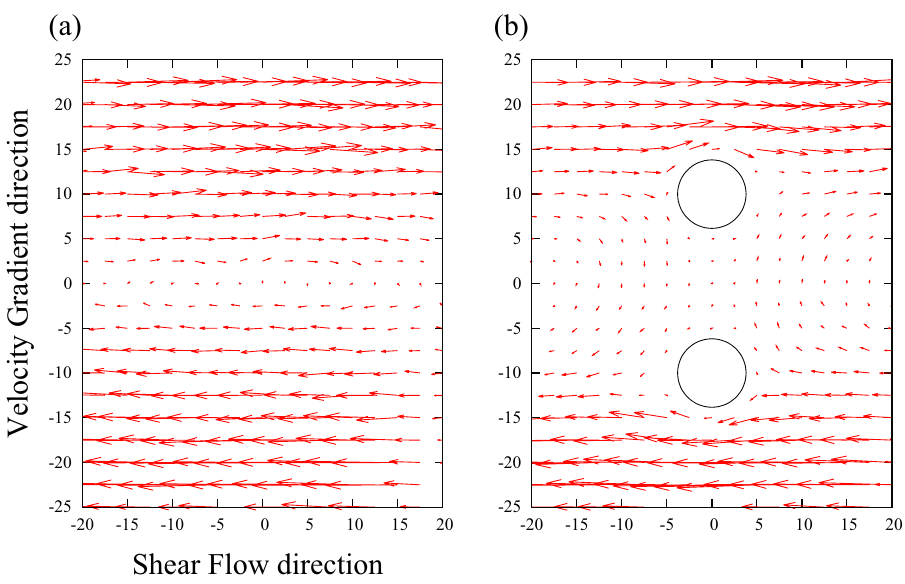
Figure 4. The velocity distribution of the particles ( a ) in the shear flow direction and ( b ) between two rigid bodies, which are represented by